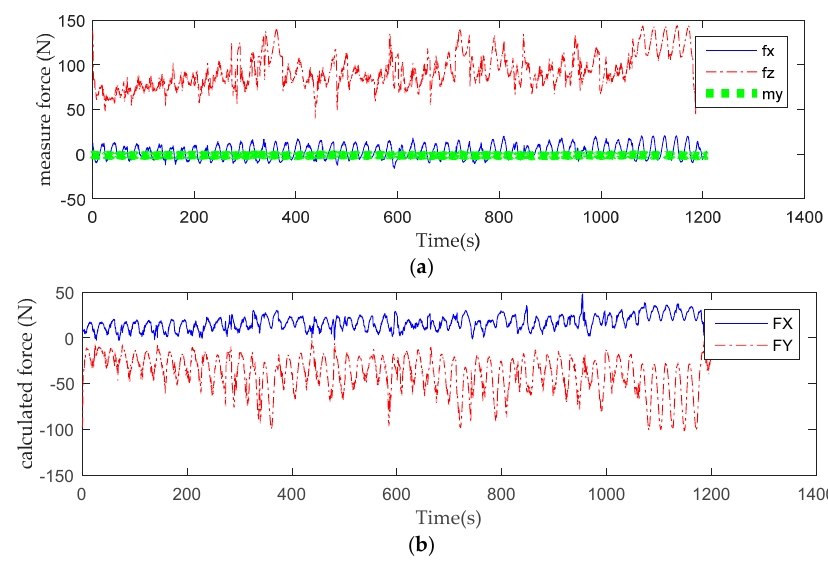
Figure 8. Sensors measuring terminal force during training: ( a ) Human–computer interaction of six-dimensional force acquisition under the training task of assistant force parameter K = 0.4; ( b ) the calculated terminal force in robot coordinates under the training task of assistant force parameter K = 0.4.